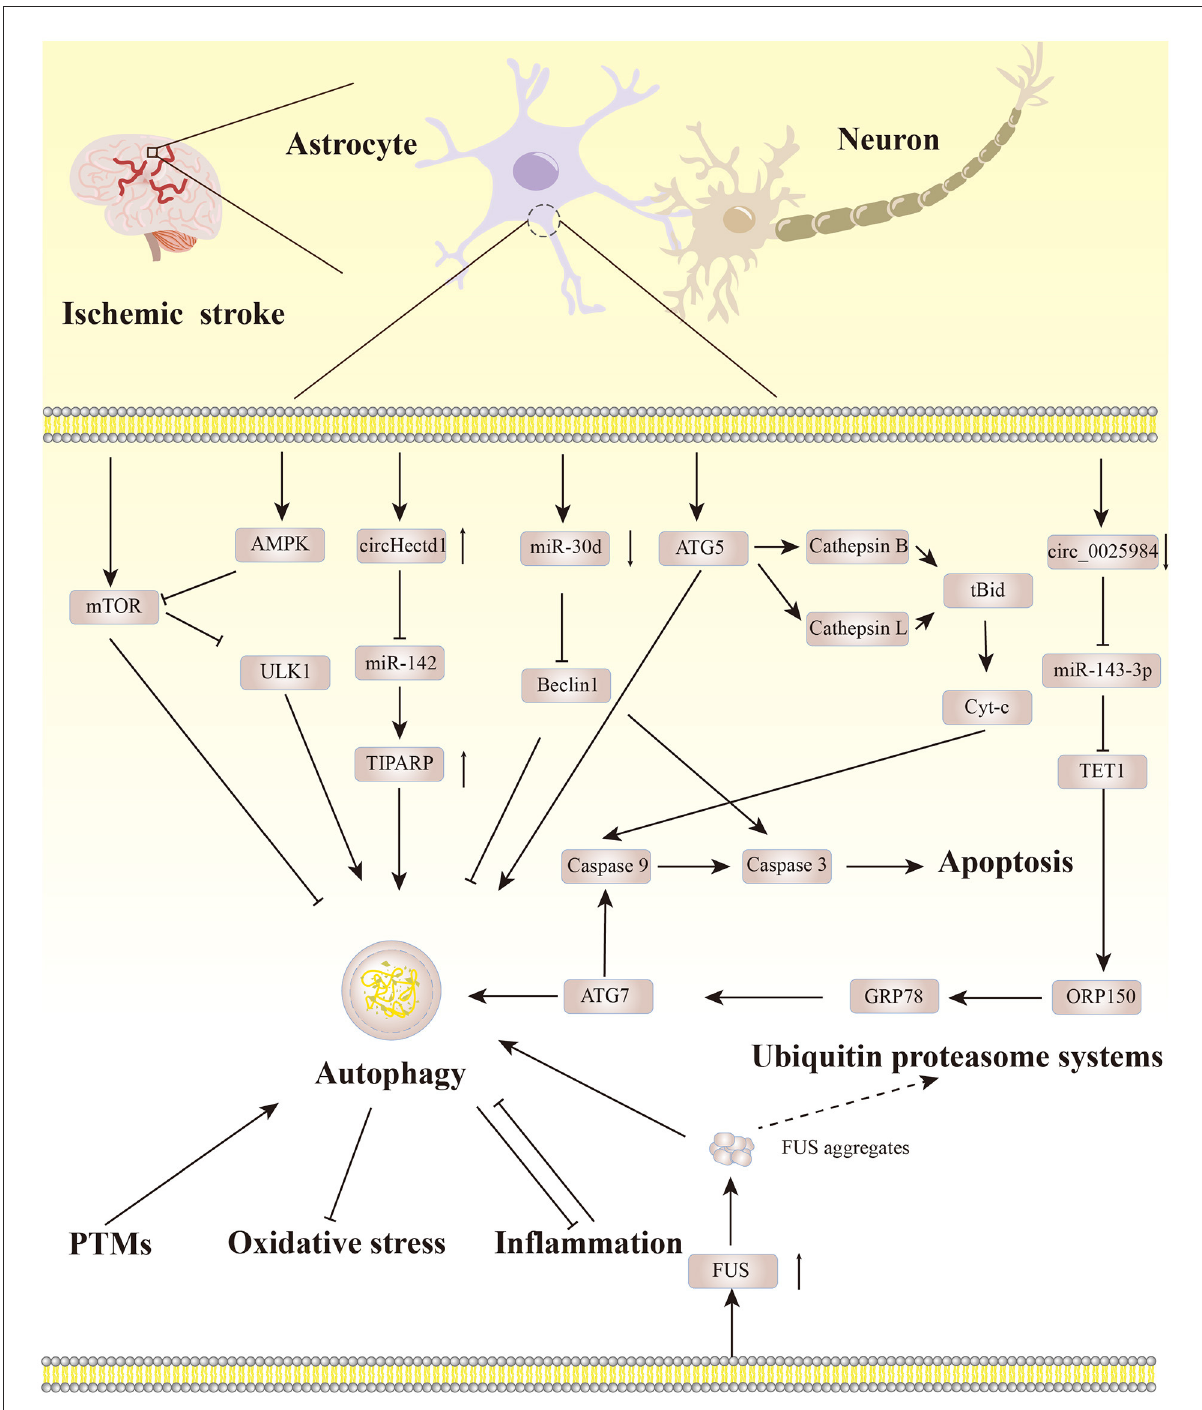
FIGURE3 The regulatory pathways involved in astrocyte autophagy in ischemic stroke.